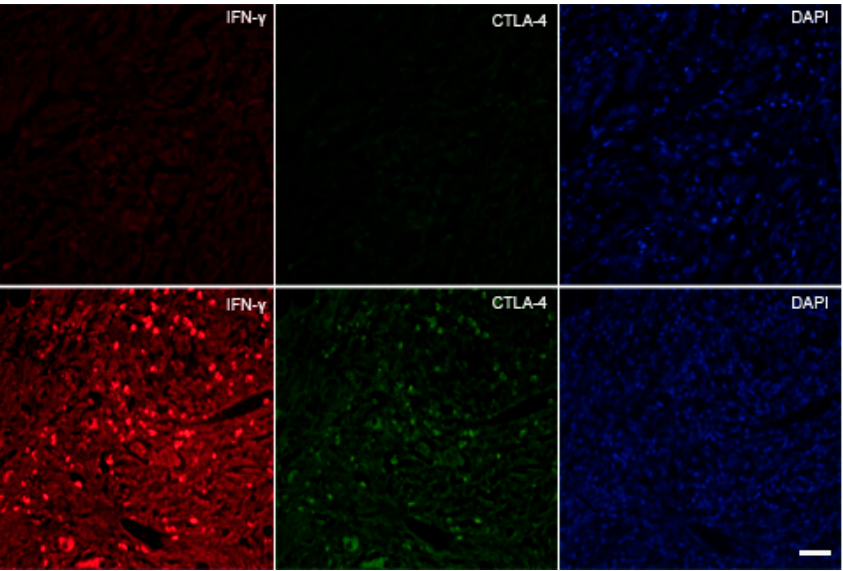
Figure 2. IFN- γ expression in the cytoplasm of ( a ) dysplastic epithelial cells in gastric mucosa and ( b ) a diffuse type of gastric cancer and tumor cells in metastatic lymph node. ( c ) IFN- γ -positive cells (arrowheads), CTLA4+ cells (arrows), indirect double immunohistochemistry, chromogen DAB for CTLA4 and fast red for IFN- γ . Scale bar ( a ) 50 µm, ( b ) and ( c ) 80